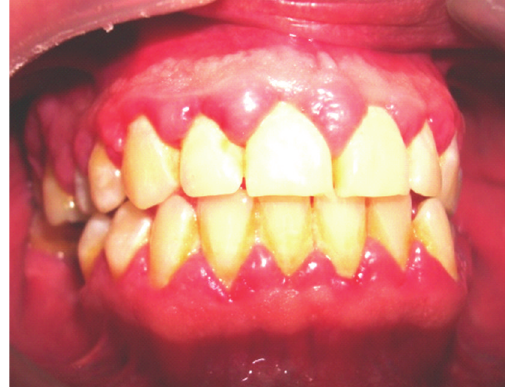
Figure 3: Gingival enlargement with signs of inflammation and presence of dental calculus in the lower third of the dental crowns (49-year-old male kidney transplant patient who was treated with